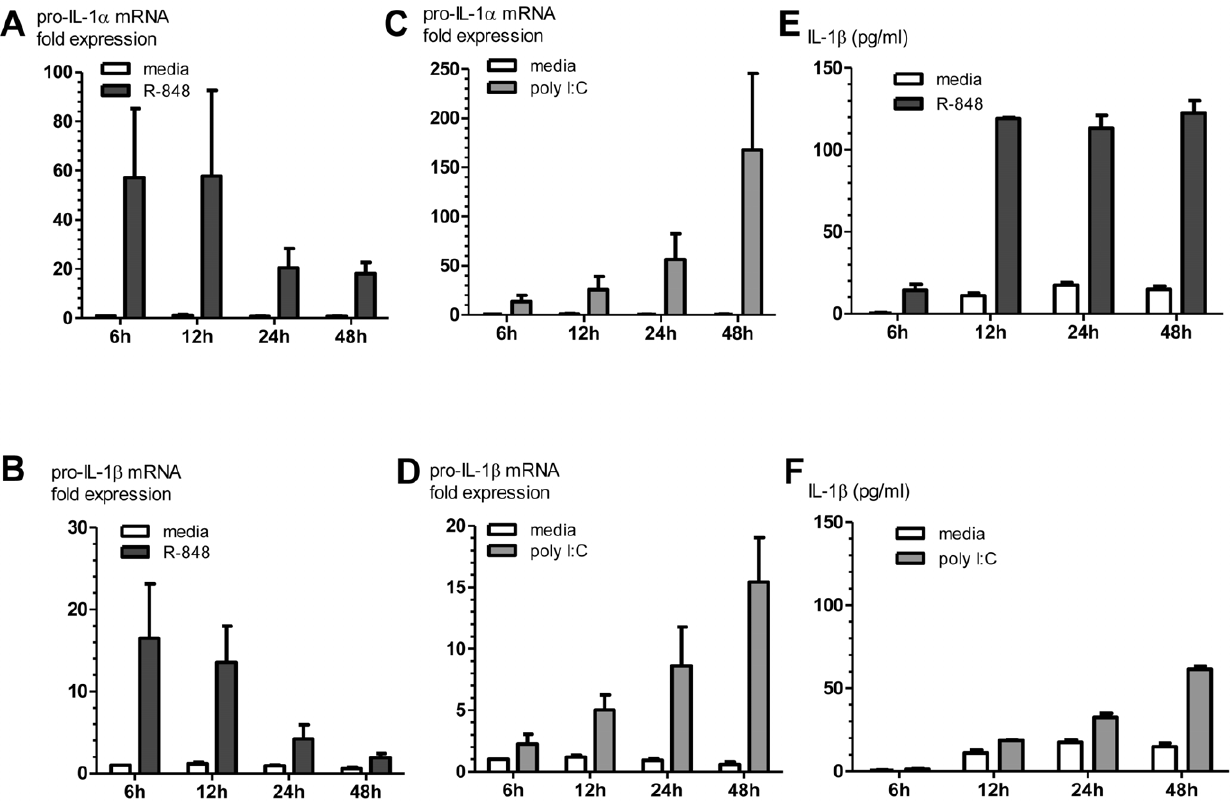
Figure 5. R-848 induces a rapid increase in pro-IL- 1 a and pro-IL-1 b mRNA expression and protein production in cDCs. cDCs were stimulated with R-848, poly I:C, or media (unstimulated control), and cellular RNA and cell culture supernatants were collected at the indicated time points. Pro-IL- 1 a (A&B) and pro-IL-1 b (C&D) mRNA levels were measured by qRT-PCR, as described in the Methods section. Bars represent fold- change in pro-IL- 1 a or pro-IL-1 b mRNA relative to unstimulated control at the 6 h time point (mean 6 SEM, n=3). (E&F) IL-1 b protein levels (precursor and mature forms) were measured in cell culture supernatants by ELISA (mean 6 SEM, n=2).